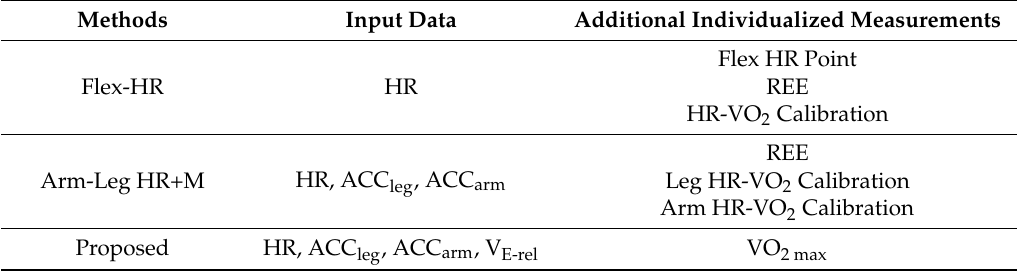
Table 3. A comparison of requirements of input data and personalized measurement among the three